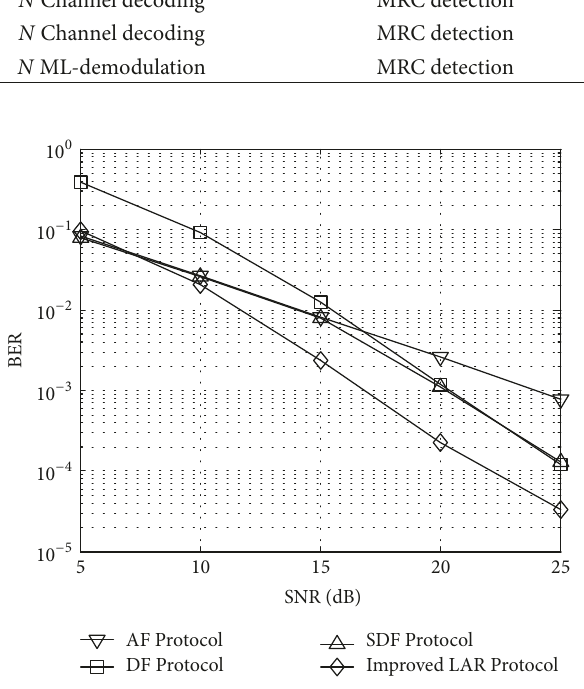
Figure 2: The BER performance of the scheme with an